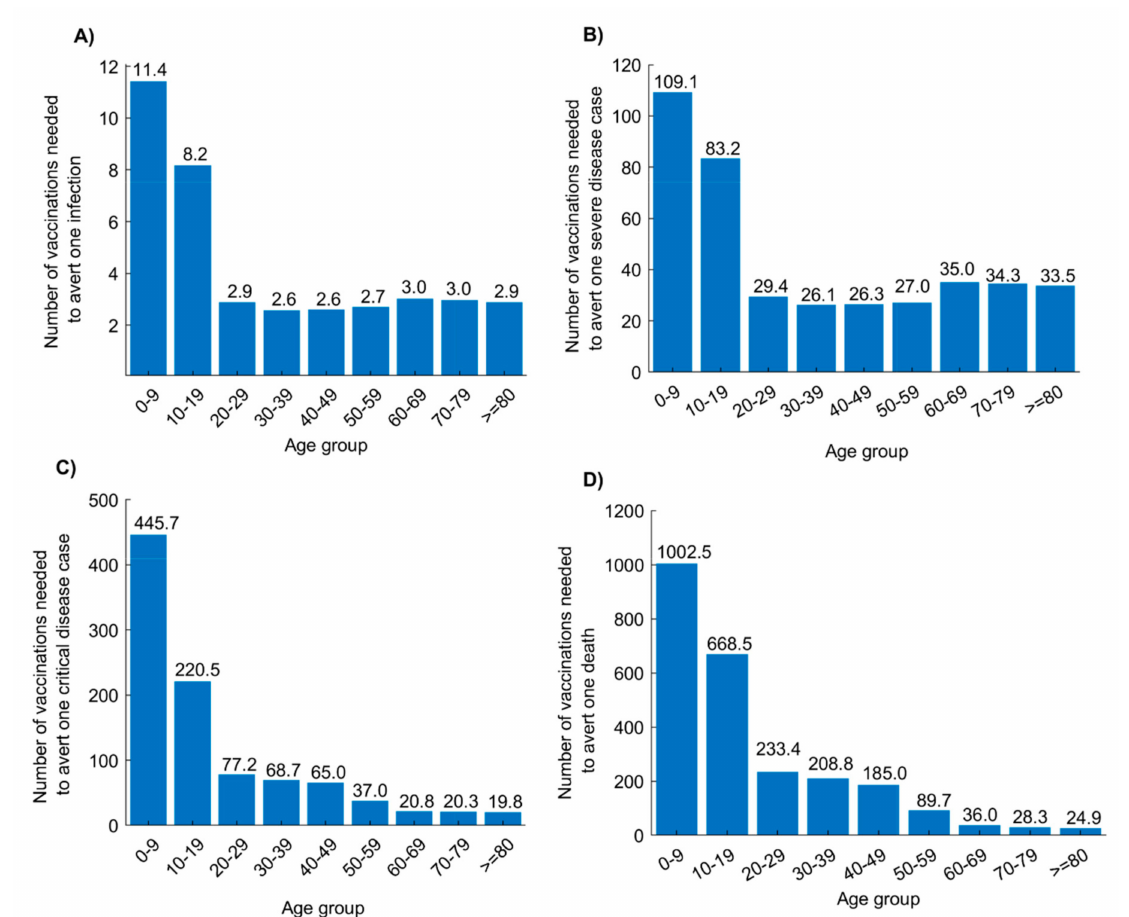
Figure 4. E ff ectiveness of age-group prioritization using a SARS-CoV-2 vaccine with VE s of 50%. Number of vaccinated persons needed to avert ( A ) one infection, ( B ) one severe disease case, ( C ) one critical disease case, and ( D ) one death by prioritizing di ff erent age groups for vaccination. Scenario assumes vaccine scale-up to 80% coverage before epidemic onset and duration of vaccine protection of 10 years. E ff ectiveness is assessed at the end of the epidemic cycle, that is, after the epidemic has reached its peak and declined to a negligible